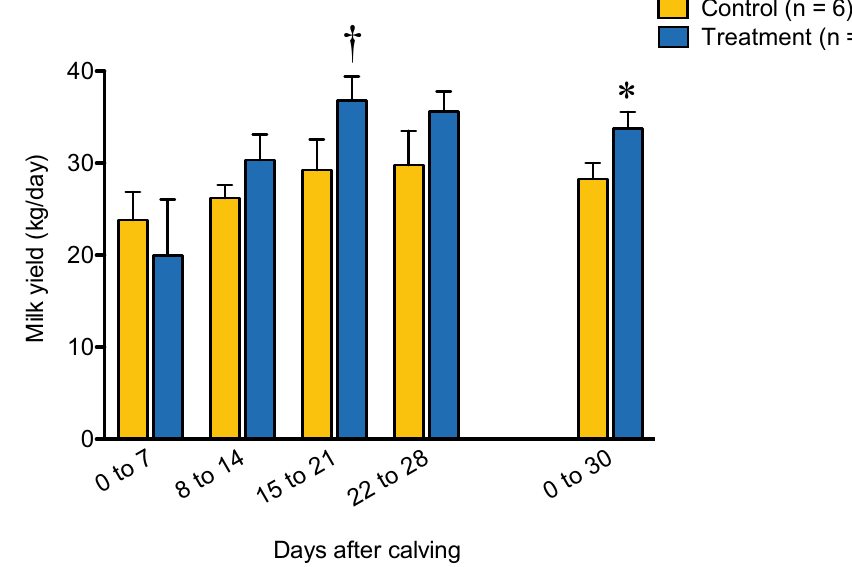
Figure 5. Average milk yield during the first 30 days of the lactation period. Milk yield was aggregated weekly or monthly, and P -values were calculated using the Welch’s t -test between the dietary groups at each time point. Asterisk (*) and dagger (†) indicate significance ( P < 0.05) and tendency ( P < 0.10),